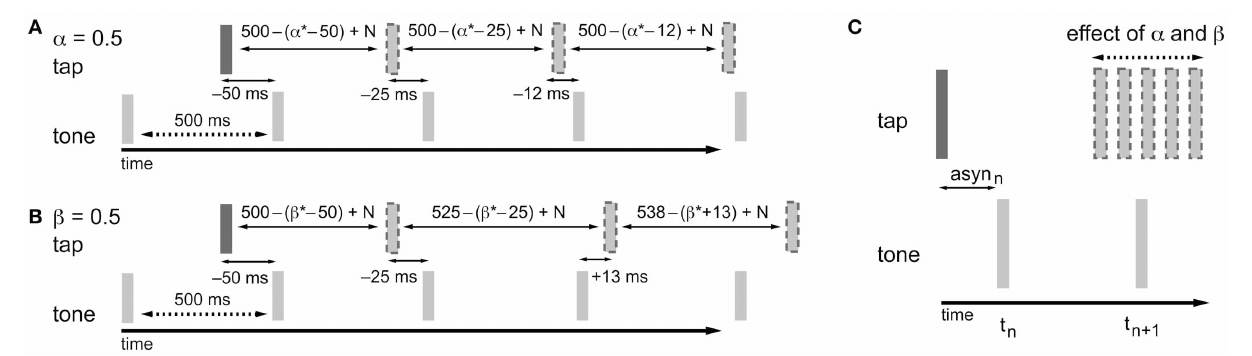
FIGURE 2 | Adaptation processes based on the asynchrony following the information-processing theory. In the examples, α and β are both equal to 0.5, which is a value that fits within the typical range of empirical α and β estimates (0.2–0.8). The examples given show how the timing of the next tap is adjusted to compensate for the asynchrony. As a result of the timekeeper setting, the asynchrony (asyn) in combination with error correction mechanisms, and motor and timekeeper noise [ N (which is set to zero in the present example)] the next tap is shifted in the opposite direction of the